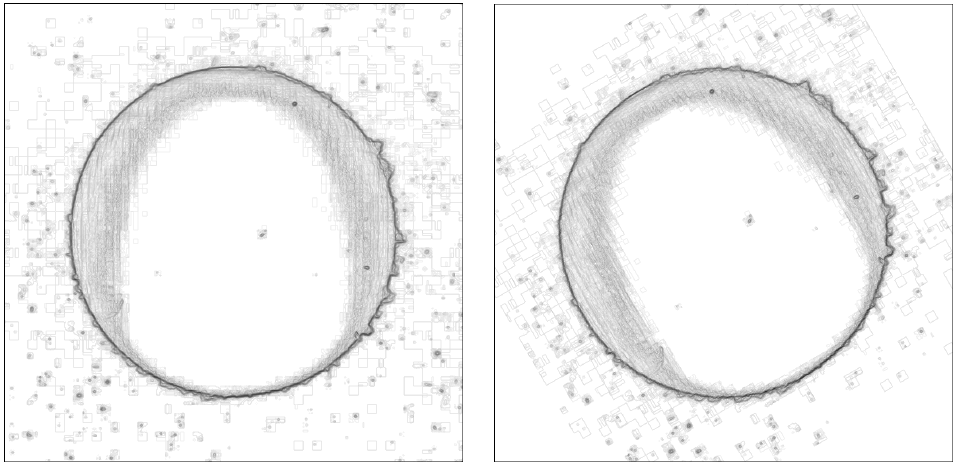
Figure 1. Comparison of gradients. Rotated image has visible blank